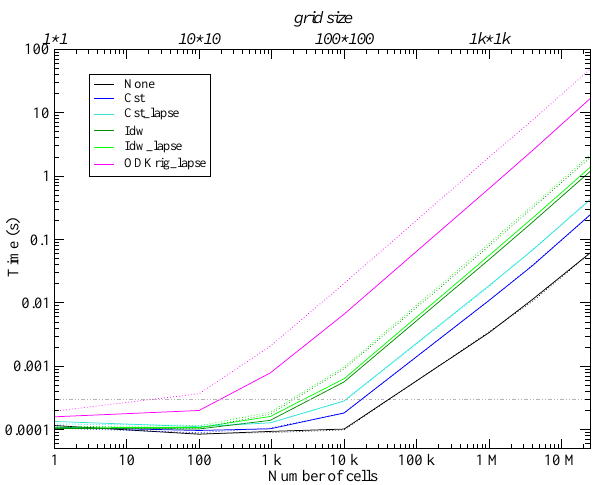
Figure 11. Benchmarks of some spatial interpolation algorithms for various grid sizes for 7 input stations (plain lines) and 14 input sta- tions (dotted